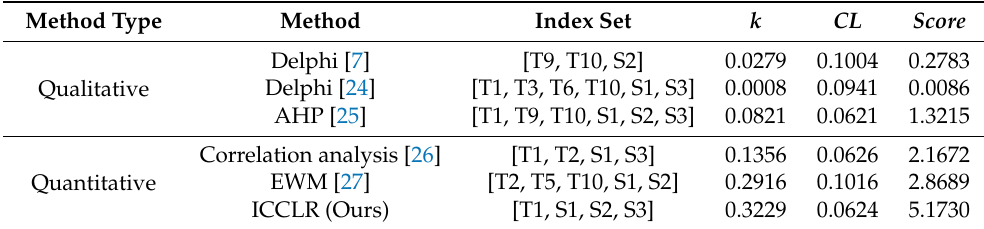
Table 5. Comparison results of different index sets.